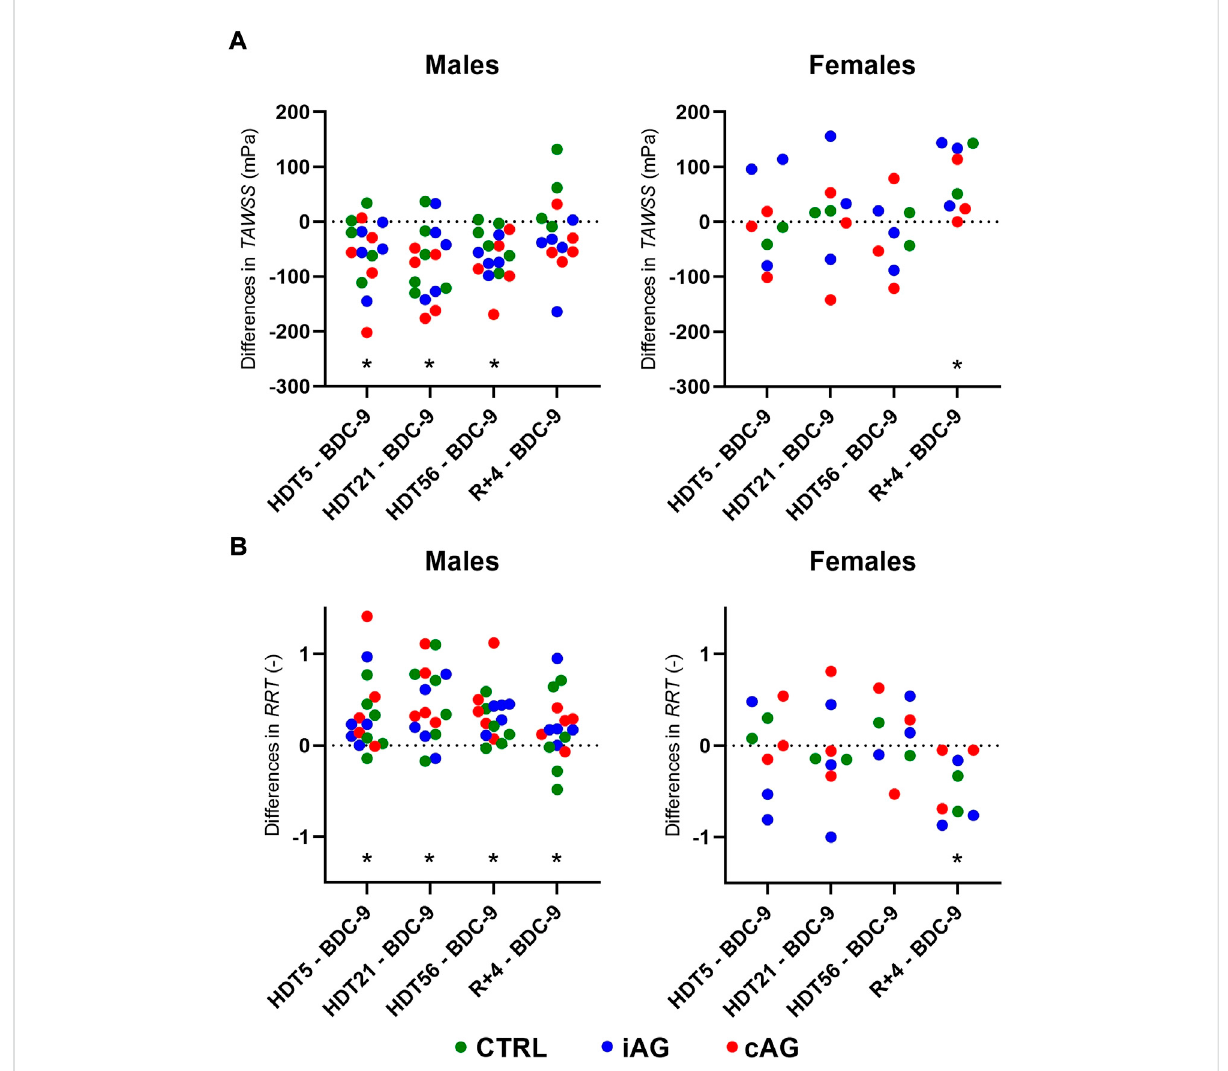
FIGURE 4 Individualevolutionof: (A) TAWSS and (B) RRT amongmalesandfemalesandineachgroupatdifferenttimepoints,comparedtotheirbaselinevalues. *: Signi fi cant difference with BDC-9 using the two-stage linear step-up procedure of Benjamini, Krieger, and Yekuteli with a false discovery rate set at 0.05. cAG: continuous arti fi cial gravity, iAG: intermittent arti fi cial gravity, CTRL: control, BDC: baseline data collection, HDT: head-down tilt, R: